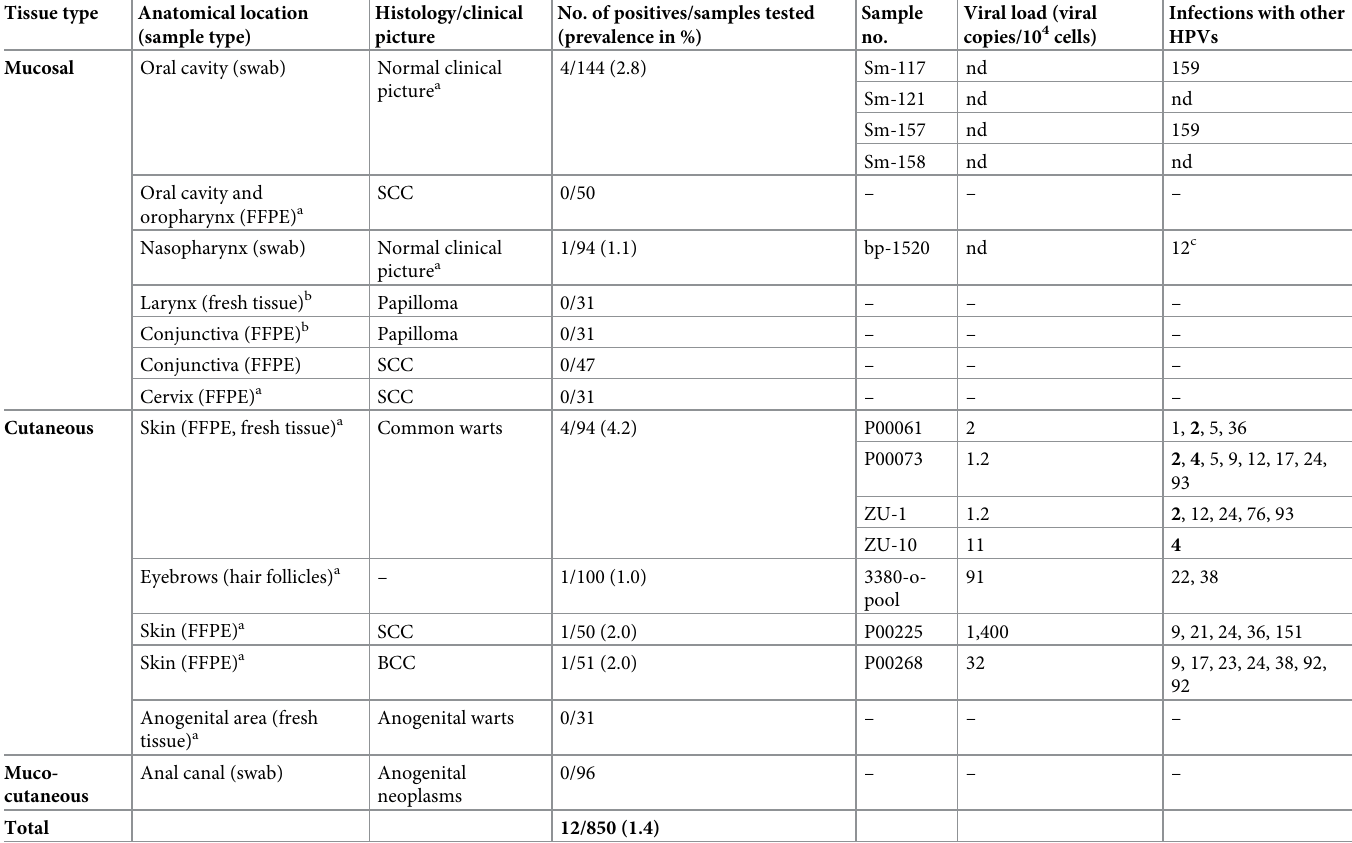
Table 1. Prevalence and tissue tropism of human papillomavirus type 179 (HPV179) in immunocompetent individuals. Tissue